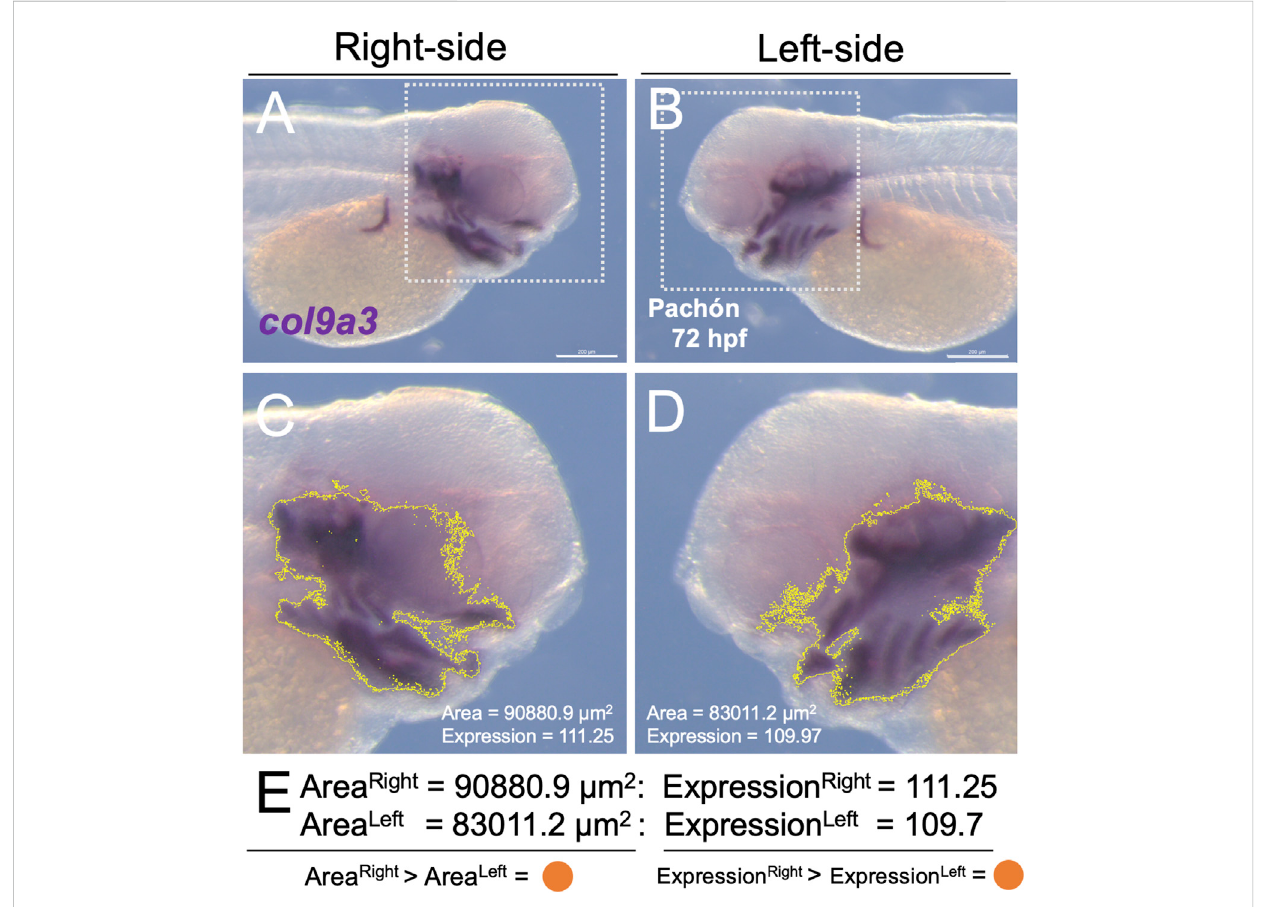
FIGURE 1 Adirectmethodforquantifyinggeneexpressionareaandlevelonthedevelopinglateralhead.Usingtheopen-sourcesoftwareprogramImageJ,we de fi ned the area of gene expression, and quanti fi ed the level of expression within that area using a semi-automated approach. The lateral sides of the embryo [ (A) , right; (B) , left] were imaged following in situ hybridization for one of 19 probes. A region of the head was delimited in each image [white dotted box in (A,B) ]. The limit of expression for the probe (in this example, col9a3 ) was automatically outlined in yellow (C,D) using ImageJ, which capitalized on the purple hue of the substrate used in our whole-mount in situ hybridization protocol. Note that the purple hue was calibrated (based on H, S, B values, see Methods) consistently applied across all specimens (cave and surface). From this region, we calculated the area (µm 2 ) and relative expression of the purple substrate (scale 0-255), as a proxy for expression level. We then determined the larger value (in this case the right side, represented as an orange dot) for both area and expression. A summary of all individual, and averaged aggregate data ( n = 4) is presented in Figure 2. Scale = 200